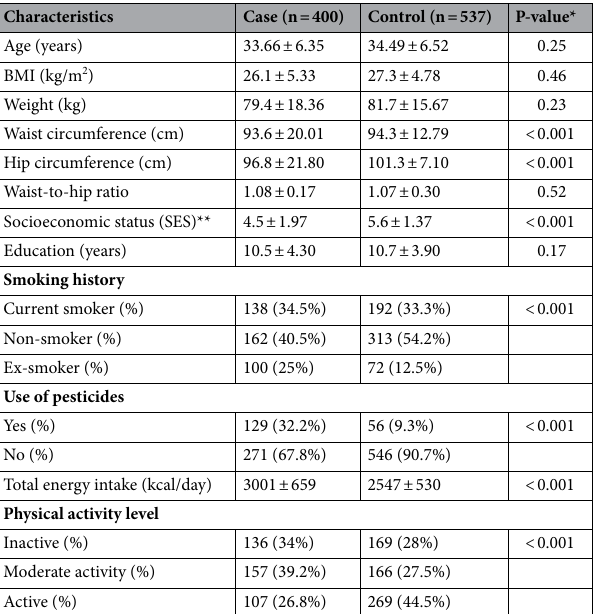
Table 1. The characteristics of Iranian men in the case and control groups (number [%] unless otherwise stated). Data are presented as mean ± SD or percentage for continuous or categorical data, respectively. *P-value was determined using independent t-test for quantitative variables and Chi-square test for categorical variables. **SES was analyzed according to the following variables: residential status (landlord/tenant), use of a washing machine or dishwasher (yes/no), number of international travels, having a car (yes/no), occupation, and education (years of